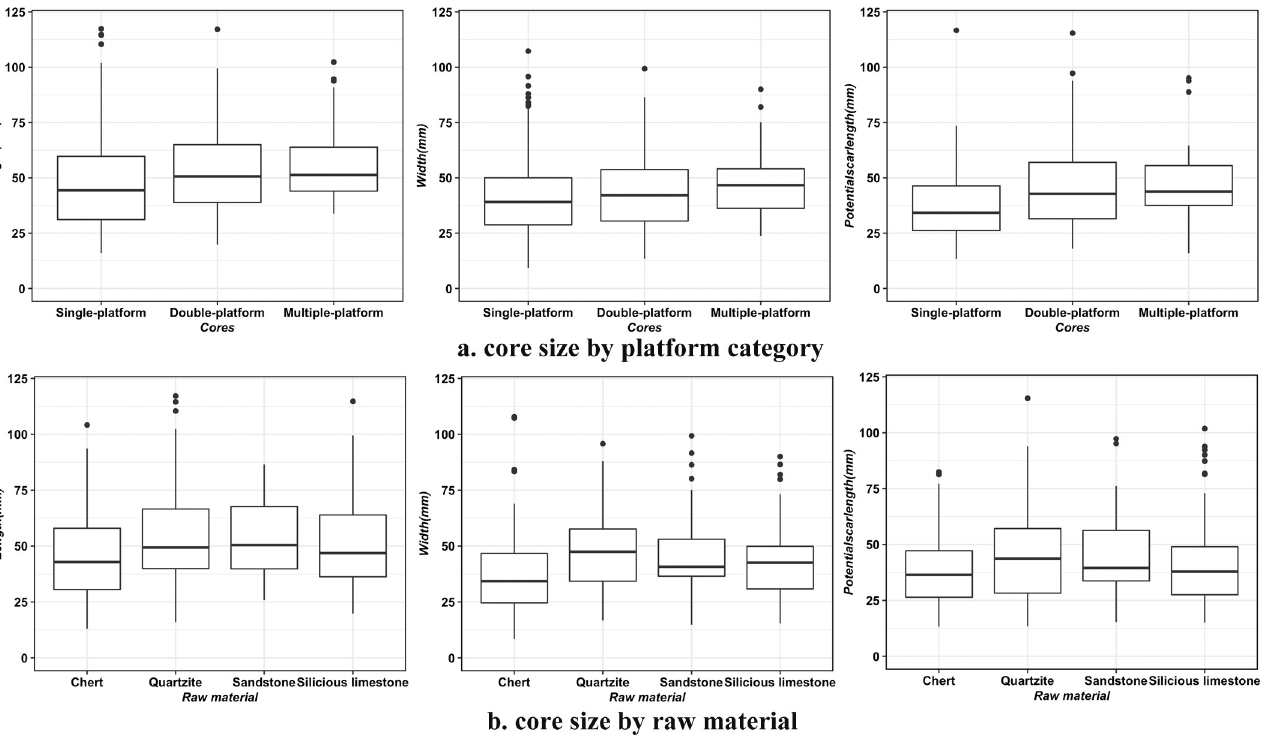
Fig 8. The comparison of core length, width, and potential scar